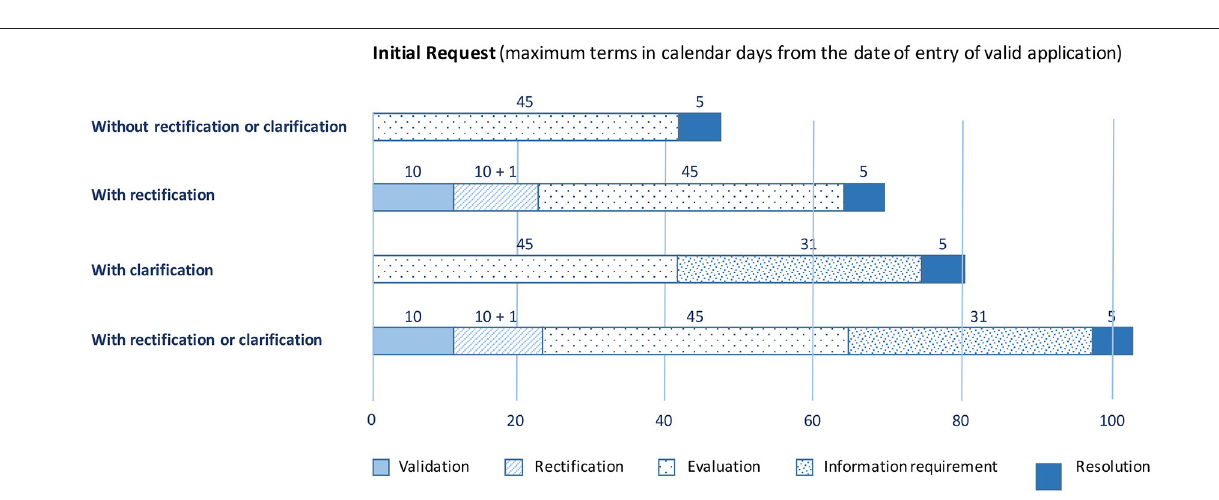
FIGURE 3 | List of documents to upload to the Spanish Agency of Medicines and Medical Devices (AEMPS) platform for investigational medicinal product (IMP) approval.